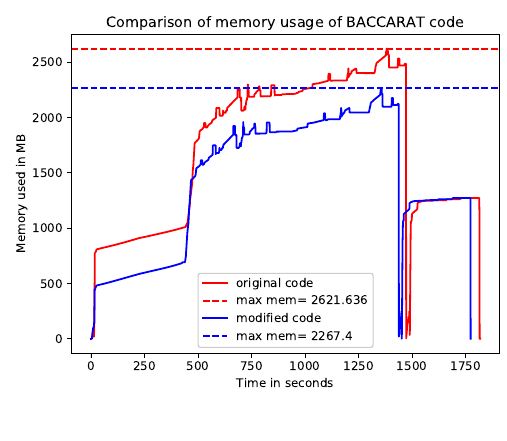
Figure 1. Comparison of memory usage of BACCARAT code before and after modifying the code to fix a memory leak. The X axis shows the wall time while the Y axis denotes the memory usage. The code has three main phases: creation of the event list , event generation and clustering and output . In this case, the change in code reduced the memory usage in the first part of the code, resulting in memory savings of about